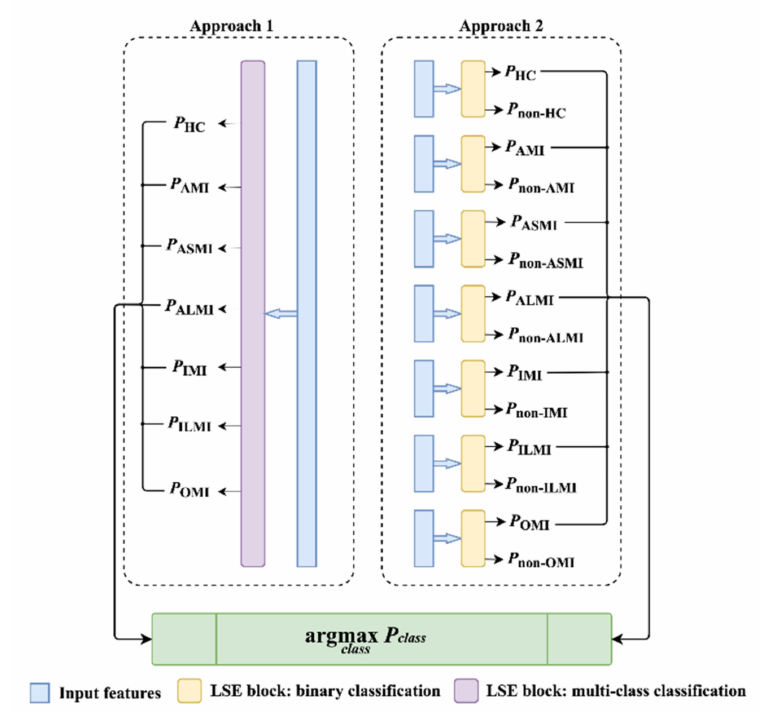
Figure 7. The implemental approaches for MI